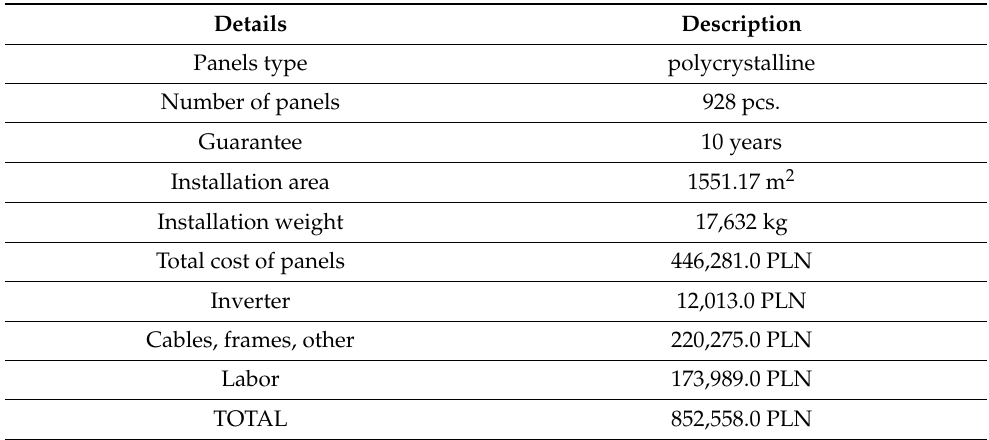
Table 13. Characteristics of offer I. Source: designed by authors using the information obtained from the